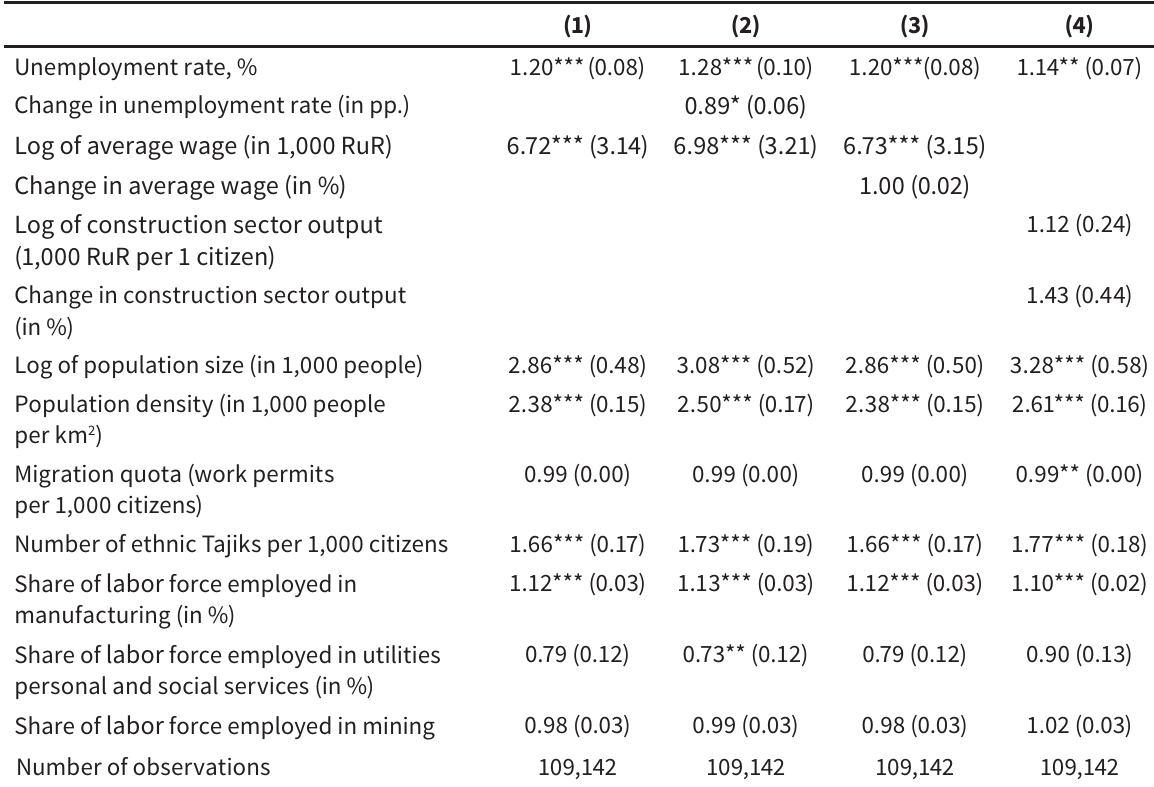
Conditional logistic regression of Tajik migrants’ choice between Russian regions, (2007, 2009, and 2011 pooled